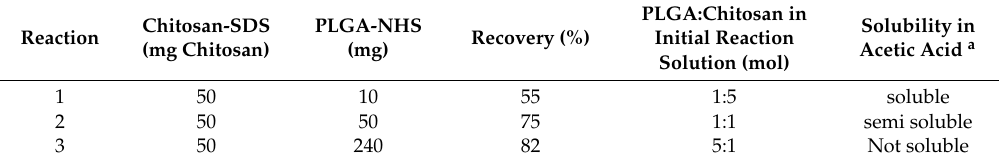
Table 1. Solution phase reaction conditions of PLGA and